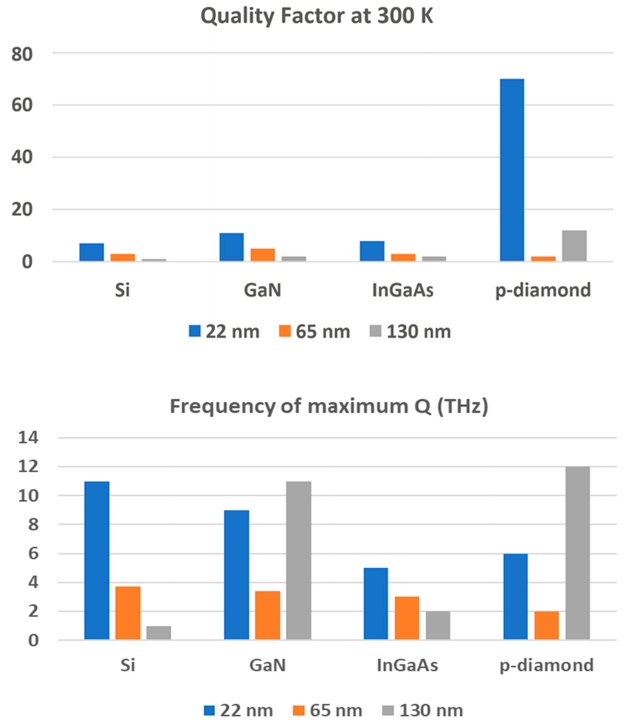
Figure 3. Estimated values of the maximum quality factor Qm, and the frequency at which this value is achieved, fm, for Si, GaN, InGaAs, and p-diamond TeraFETs (data from [92,93]). Parameters used in the calculation: mobilities for Si 0.1450 m 2 /Vs, for GaN 0.2 m 2 /Vs, for InGaAs 1.2 m 2 /Vs, and for p-diamond 0.53 m 2 /Vs; effective masses: for Si 0.19, for GaN 0.23, for InGaAs 0.041, and for p-diamond 0.663.